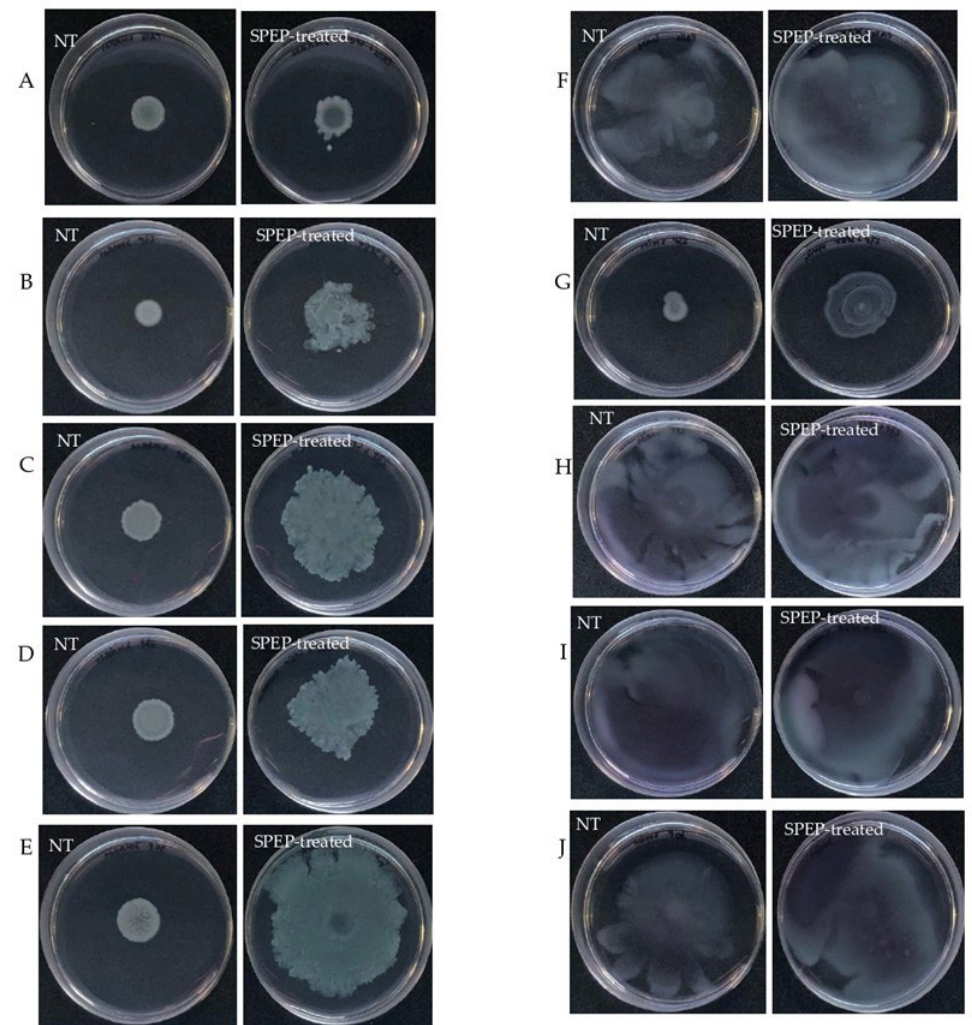
Figure 6. Motility assay (Petri plates diameter 8.5). Left Panel; Swarming assay of reference and clinical strains treated and not treated (NT) with SPEP. ( A ) P. aeruginosa PA14; ( B ) 23P; ( C ) 27P; ( D ) 28P; ( E ) 30P. Right Panel; Swimming assay of reference and clinical strains treated and not treated (NT) with SPEP. ( F ) P. aeruginosa PA14; ( G ) 23P; ( H ) 27P; ( I ) 28P; ( J ) 30P.